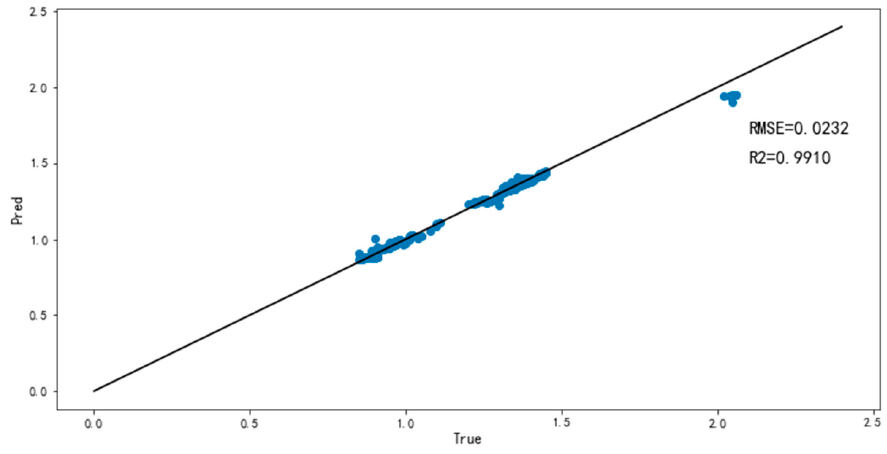
Figure 9. The test set RMSE and R 2 .